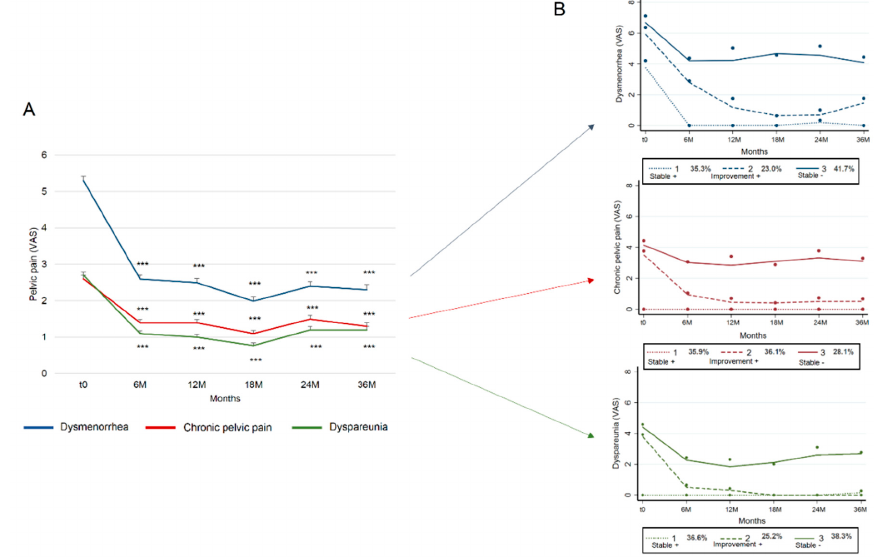
Figure 1. Trajectories of the long-term evolution of pelvic symptoms following surgical treatment for endometriosis. ( A ) Evolution of pelvic pain following surgical treatment; ( B ) Trajectories for each pelvic pain. For graph A, each curve represents mean ± standard error of the mean; ***: p < 0.001 compared to baseline. VAS: visual analog scale.